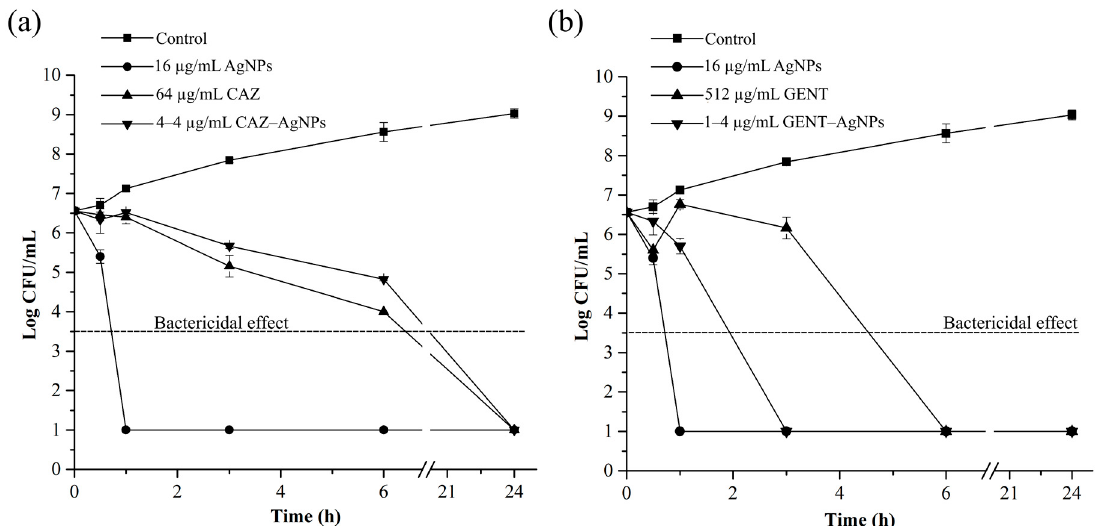
Figure 4. Changes in time-dependent killing efficiency of each antibiotic after addition of AgNPs. B. pseudomallei were treated with CAZ alone, AgNPs alone, and the CAZ–AgNPs combination ( a ) and with GENT alone, AgNPs alone, and the GENT–AgNPs combination ( b ). Bacteria were incubated at the MBC or FBC of each agent at 37 °C. The solutions were sampled at 0, 0.5, 1, 3, 6, and 24 h for colony count. A decrease in the bacterial colony ≥ 3 log 10 was defined as the bactericidal effect. The data represent the mean values ± SD (error bar) from two independent experiments each carried out in triplicate.